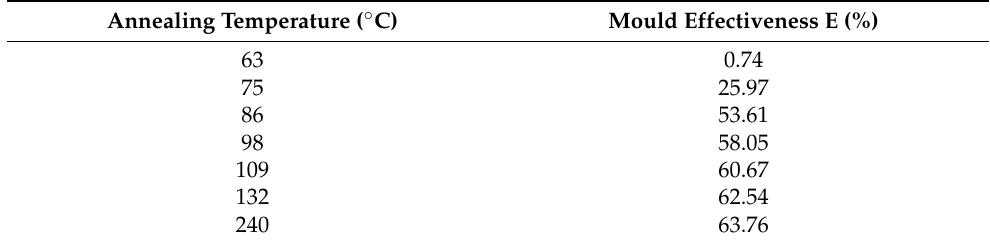
Table 7. PLA mould